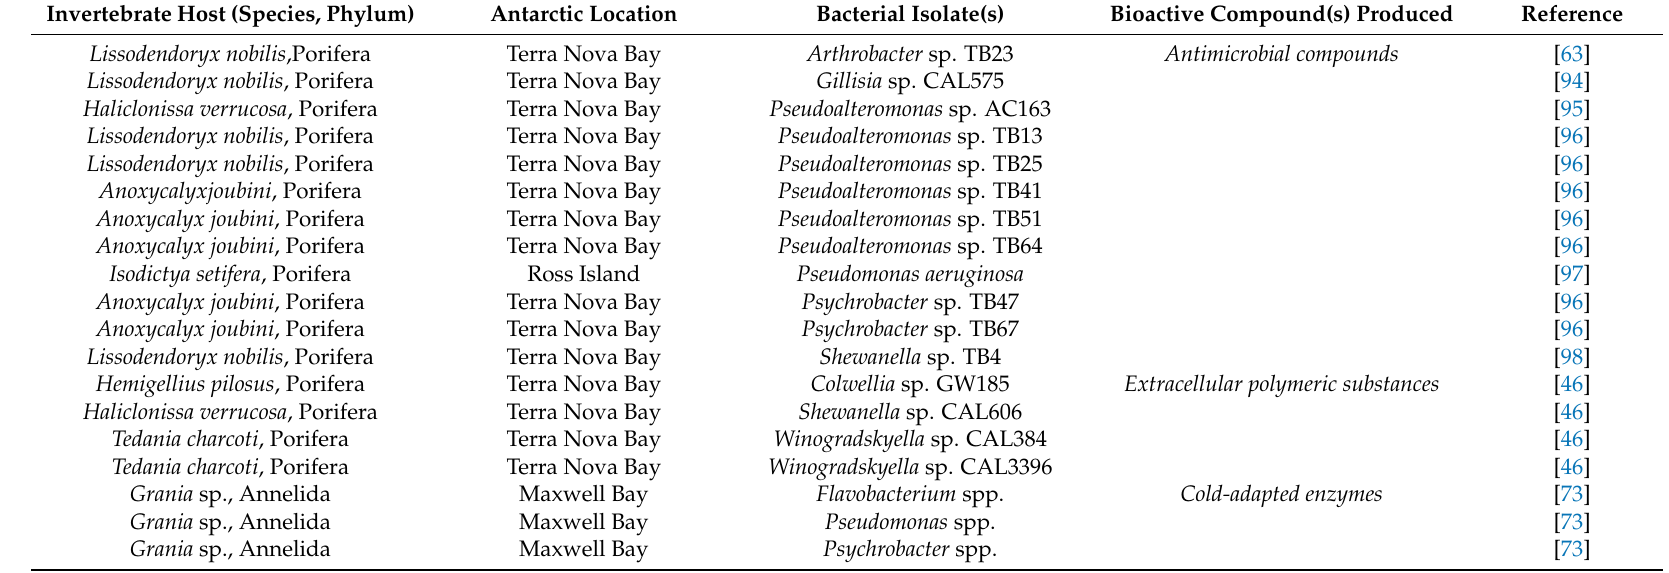
Table 2. Cold-adapted bacteria isolated from Antarctic marine benthic invertebrates as a source of